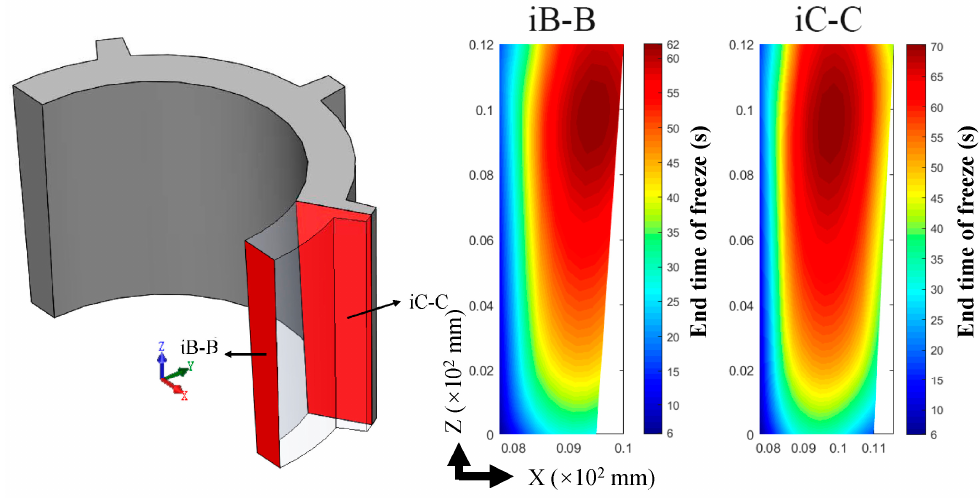
Figure 16. The end-of-freeze contours on vertical sections.